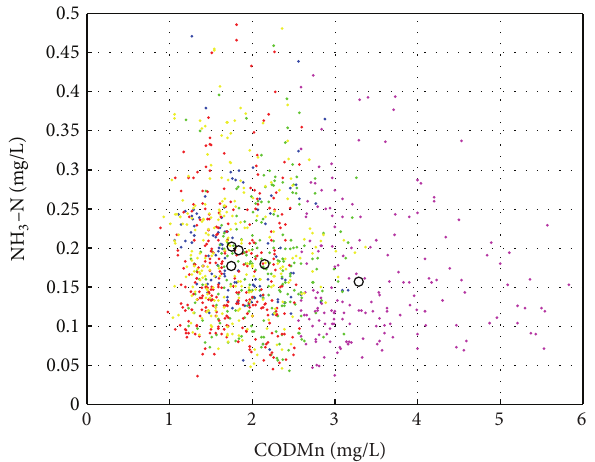
Figure 4: The distribution of water quality under the influence of CODMn and NH 3